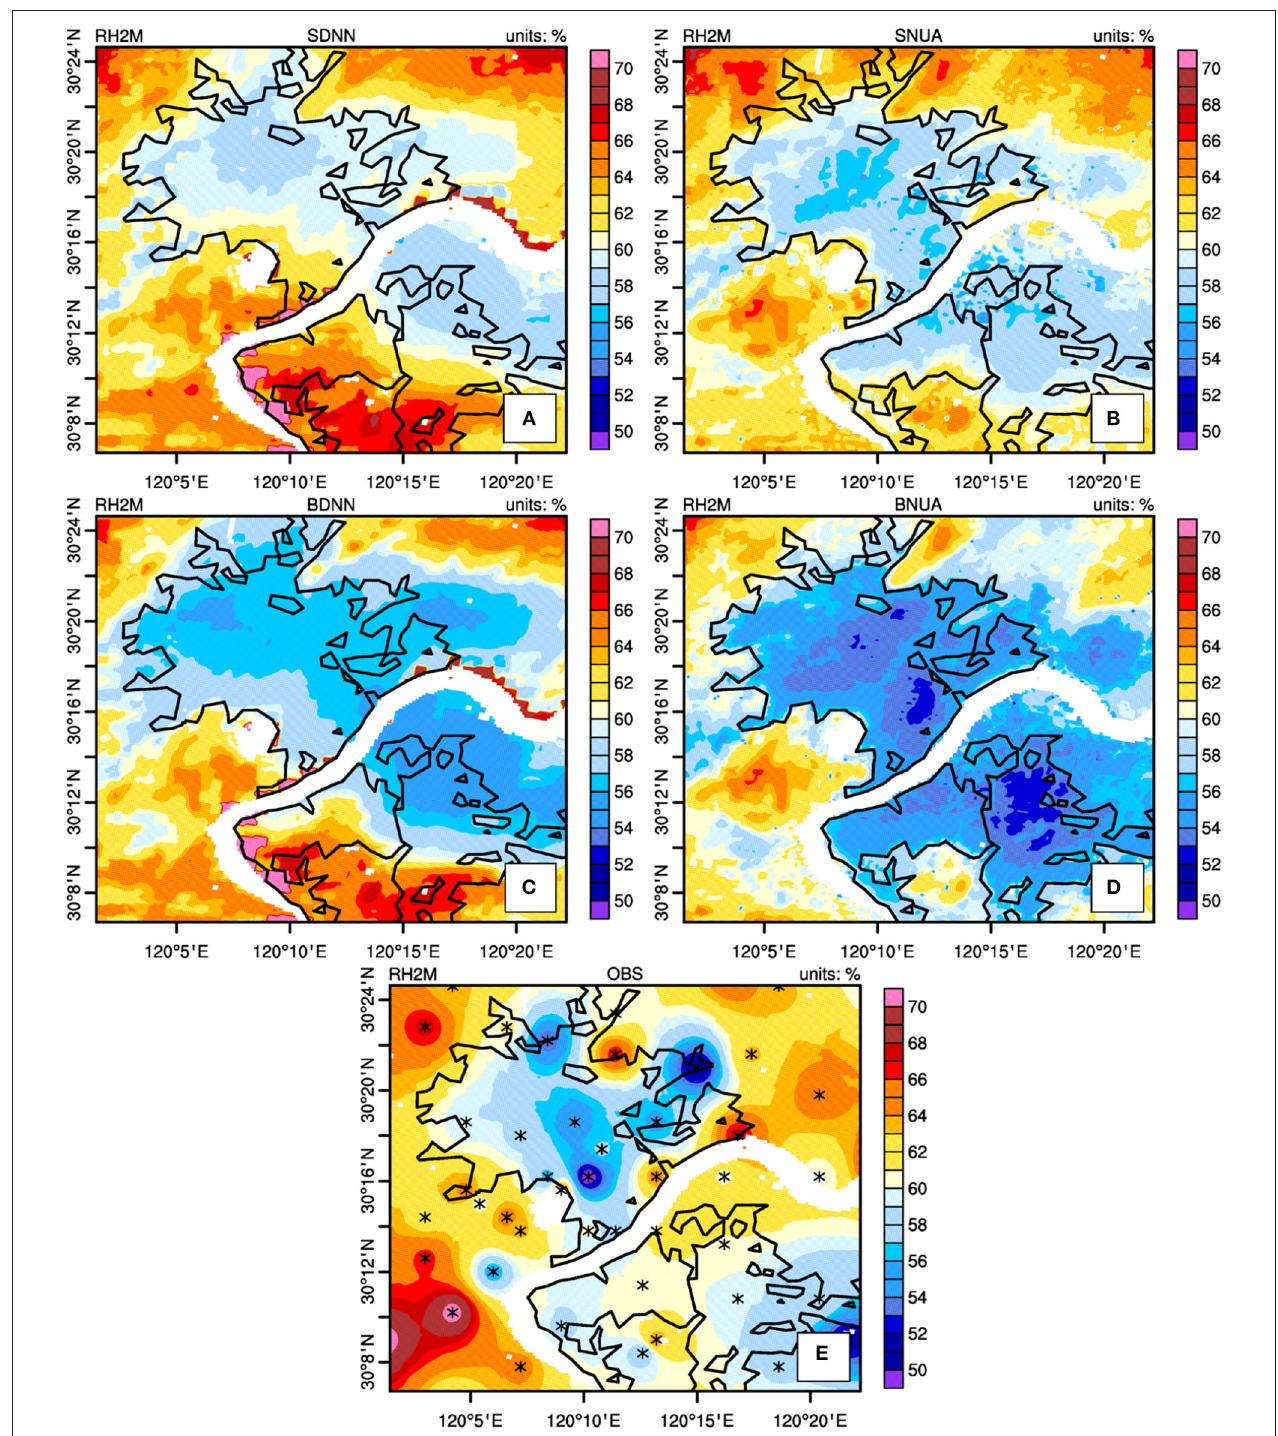
FIGURE 5 | The same as Figure 4 , but for daily mean relative humidity at 2m.